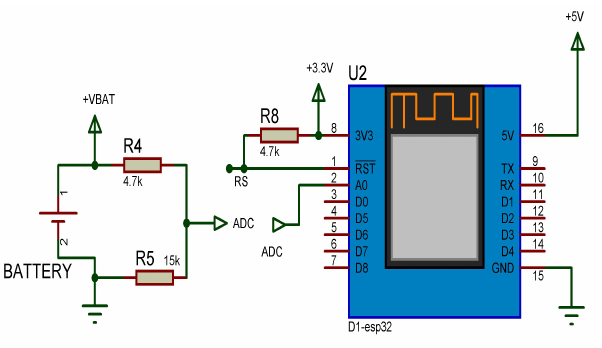
Fig 3. Structure of the wirelessly connected wearable device.